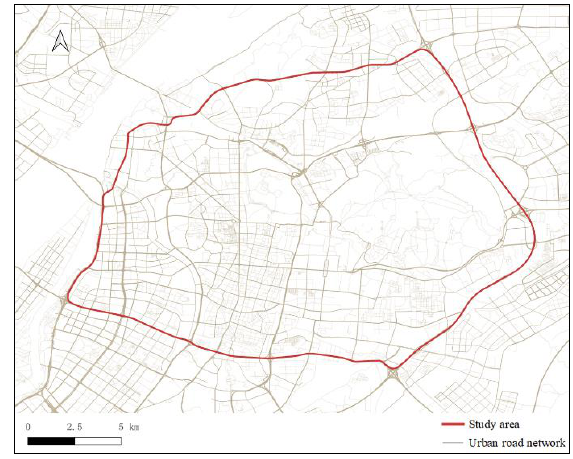
Figure 1 . The study area in Nanjing City